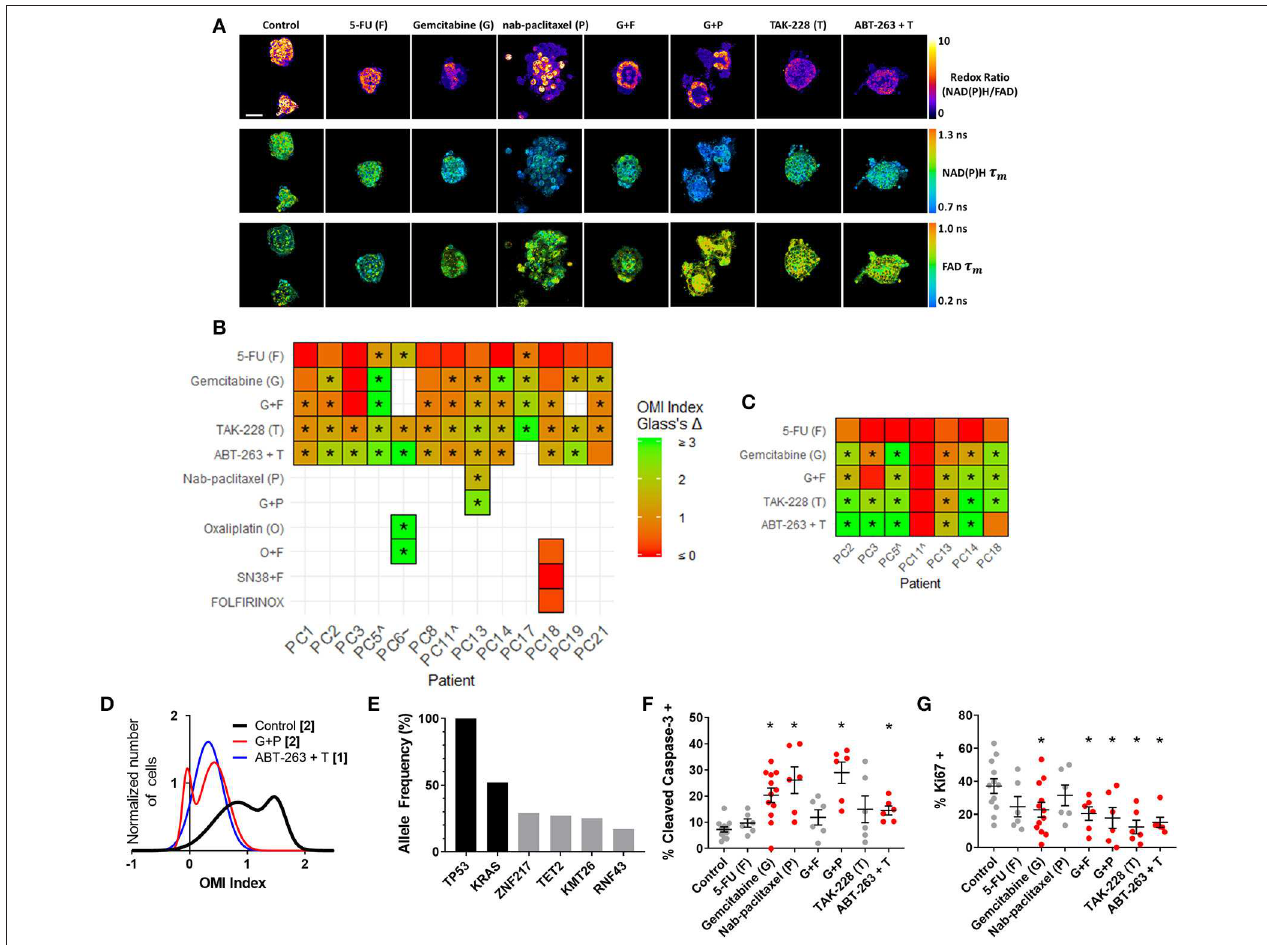
FIGURE 4 | OMI captures non-genetic cellular heterogeneity in pancreatic organoids. (A) Representative images of the redox ratio, NAD(P)H τ m , and FAD τ m , in organoids generated from Patient PC13 (anaplastic carcinoma of the pancreas), treated with standard chemotherapies and experimental targeted therapies for 72h. Scale bar is 50 µ m. (B,C) Heatmap representation of the OMI index treatment effect size (Glass’s 1 ) for all patients at 72h in organoids (B) and fibroblasts cultured with organoids. (C) “ ∧ ” indicates the patient lesion was diagnosed as PanIN. “ ∼ ” indicates the patient lesion was diagnosed as ampullary cancer. *Glass’s 1 ≥ 0.75. (D) Normalized density distributions of the OMI index of individual cells contain subpopulations with G + P treatment, but not ABT-263 + T treatment after 72h in PC13 organoids. Bracketed number indicates number of subpopulations. (E) High-depth targeted cancer gene sequencing of PC13 organoids. Allele frequencies of ∼ 50% for KRAS and 100% for TP53 were found (black bars). Alterations with allele frequencies of 10–30% were detected (gray bars), but none of these alterations were pathogenic. (F) Cleaved caspase-3 staining of PC13 organoids shows differences in apoptosis between treatment conditions after 72h of treatment. (G) Ki67 staining of PC13 organoids shows differences in proliferation between treatment conditions after 72h. Each dot represents one organoid (mean ± SEM), and red indicates significant response to treatment. * p < 0.05 vs.